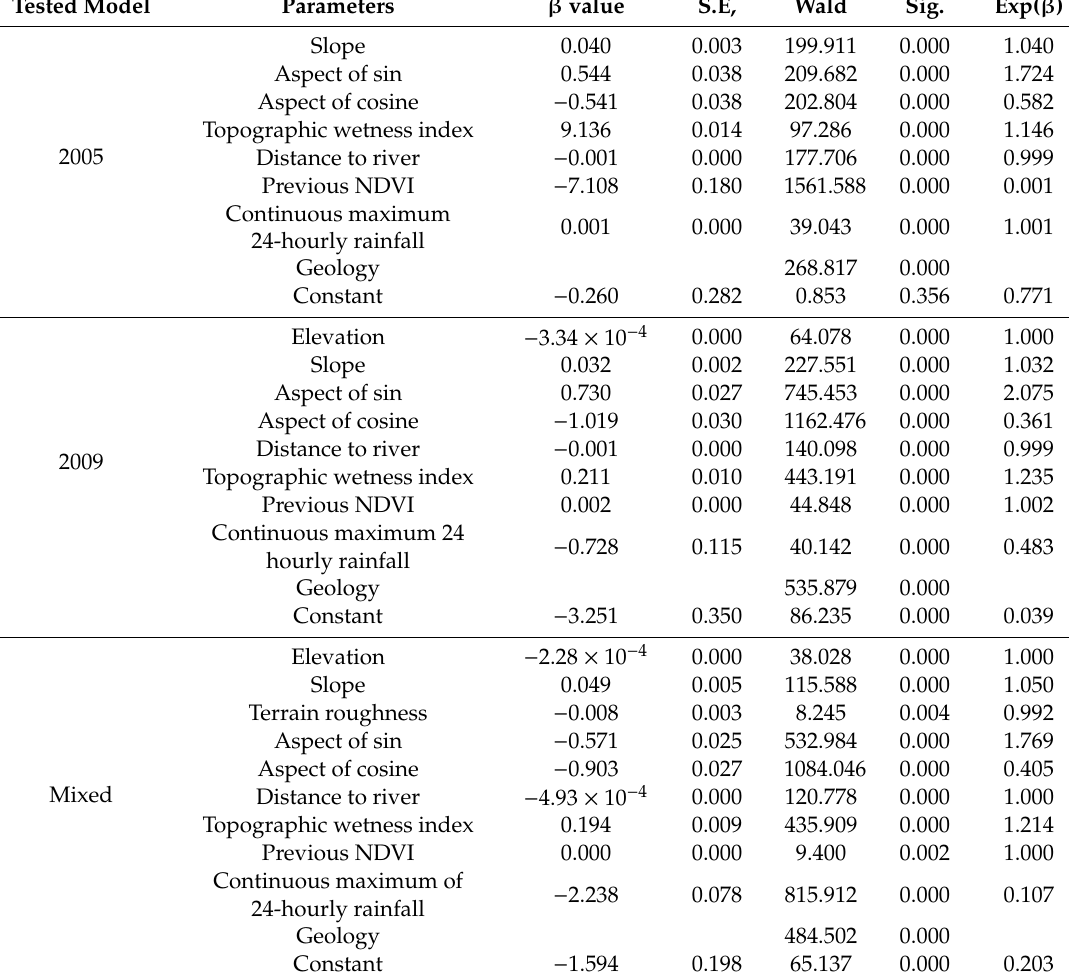
Table 3. Statistic results derived from each